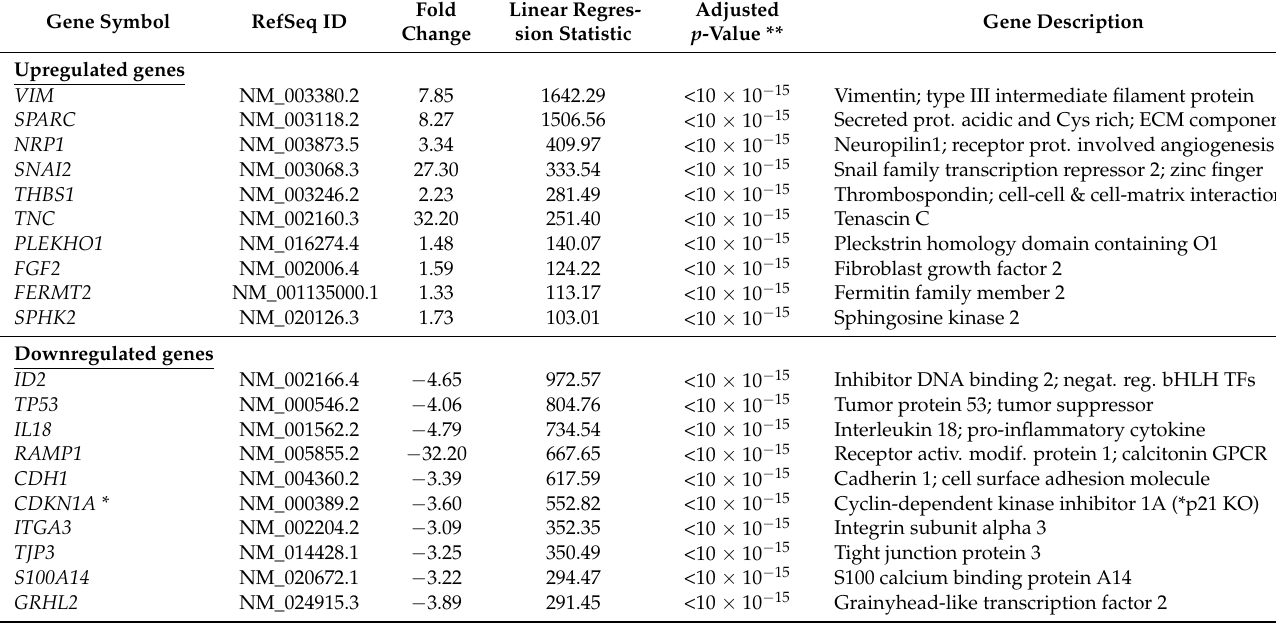
Table 1. Dysregulated genes found by the comparison of HCT116 p21 − / − cells versus HCT116 parental WT cells. The top 10 most upregulated genes and top 10 most downregulated genes are presented. All genes and additional information corresponding to the analysis are included in Supplementary Table